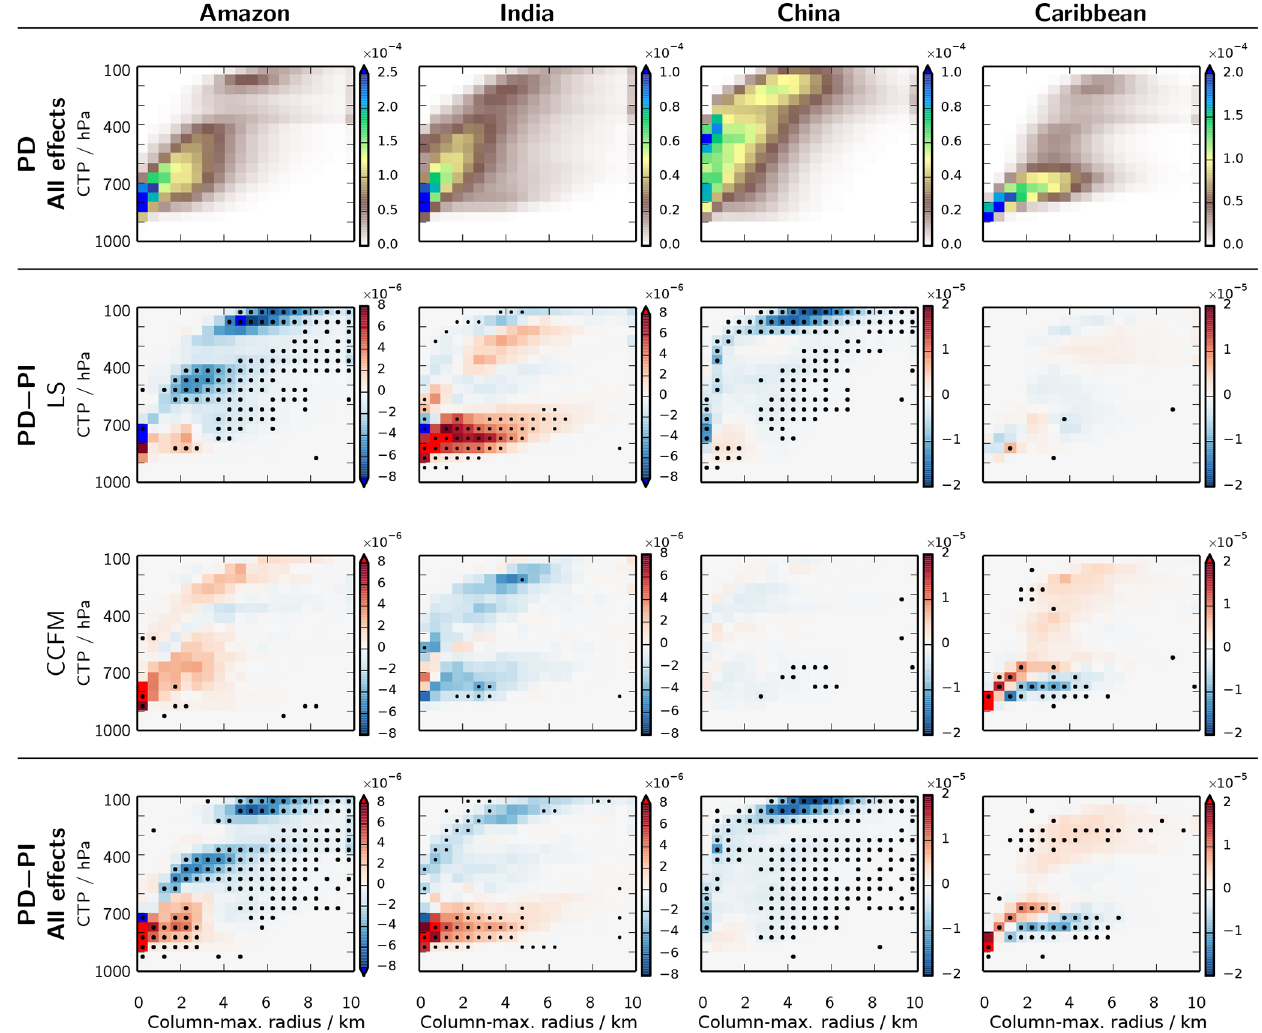
Figure 5. Regional cloud field response decomposed into its different mechanisms as listed in Table 2. The top row shows the PD distribu- tions, while the bottom row shows the PD–PI difference (both with all effects included as in Fig. 4); the middle rows show the contributions from large-scale and CCFM (convective) mechanisms. Note that the colour scales are identical between mechanisms to allow comparison of their magnitude but not between the different regions. A further breakdown into individual process effects, along with additional regions, is included in the Supplement. The radius on the x axis indicates the broadest part of a given entraining plume in the CCFM 10-member cloud-type ensemble over its whole height. (PD: present-day aerosol; PI: pre-industrial aerosol; black dots indicate histogram bins where the PD–PI difference is statistically significant at the 95%